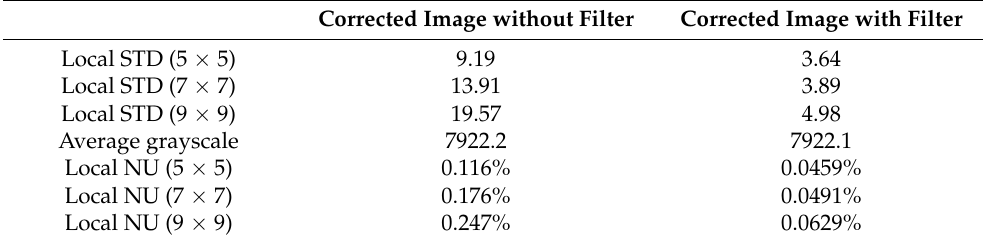
Table 4. Comparison of peak characteristics for local STD peaks and NU of different image sizes.